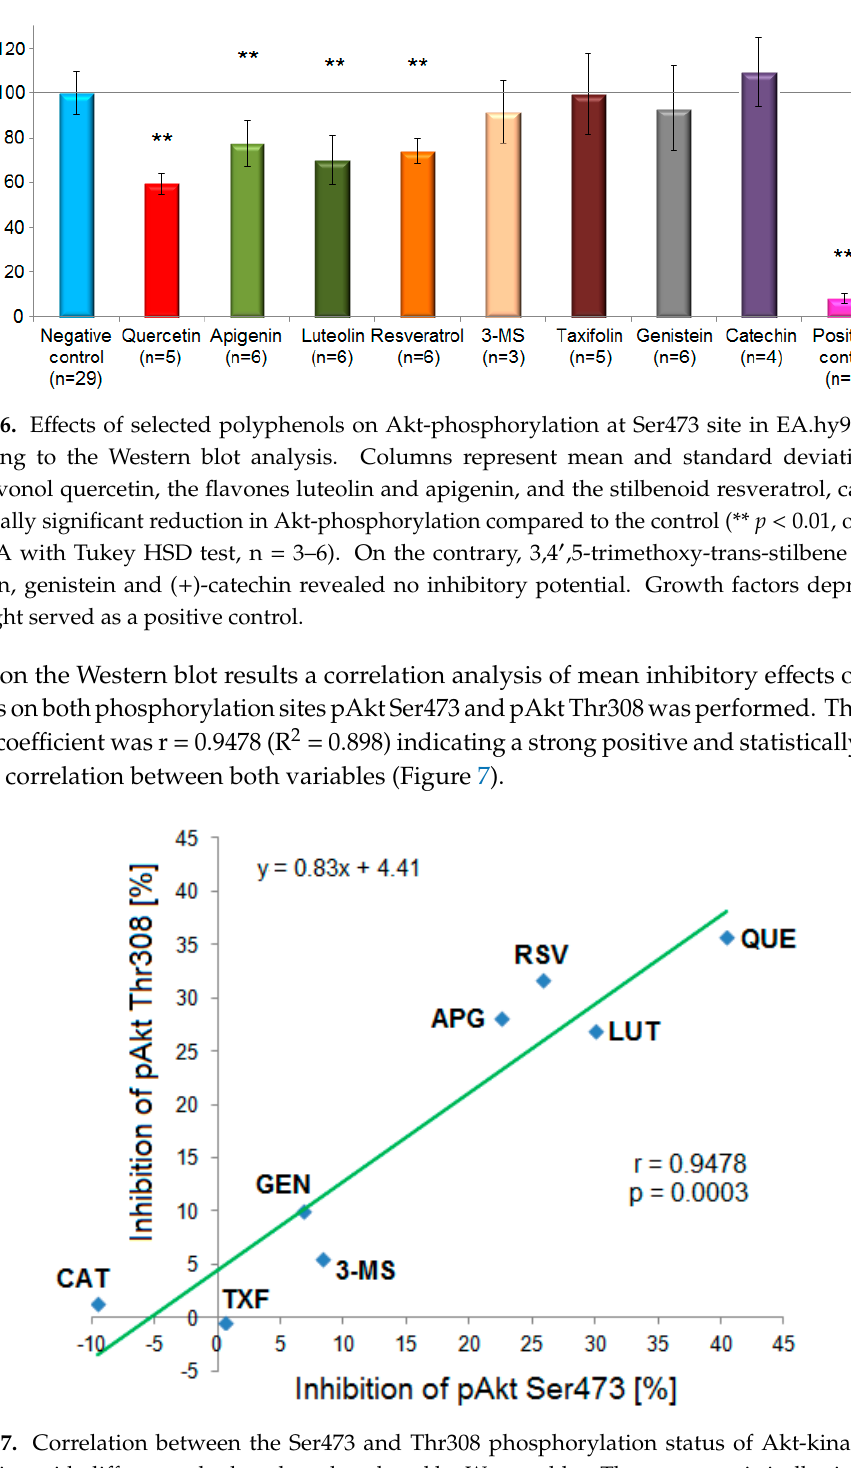
Figure 7. Correlation between the Ser473 and Thr308 phosphorylation status of Akt-kinase after correlation (r = 0.9478, p = 0.0003, n = 3–6) suggested that the compounds exhibited similar inhibitory e ff ects on both phosphorylation sites. CAT: ( + )-catechin, TXF: Taxifolin, GEN: Genistein, 3-MS: 3,4 (cid:48) ,5-trimethoxy-trans-stilbene, APG: Apigenin, RSV: Resveratrol, LUT: Luteolin, QUE: